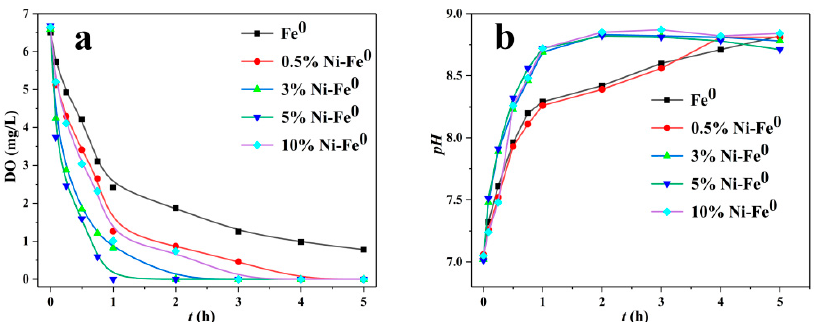
Figure 6. Changes in pH and DO during the degradation of TCE by Ni-nZVI with different nickel